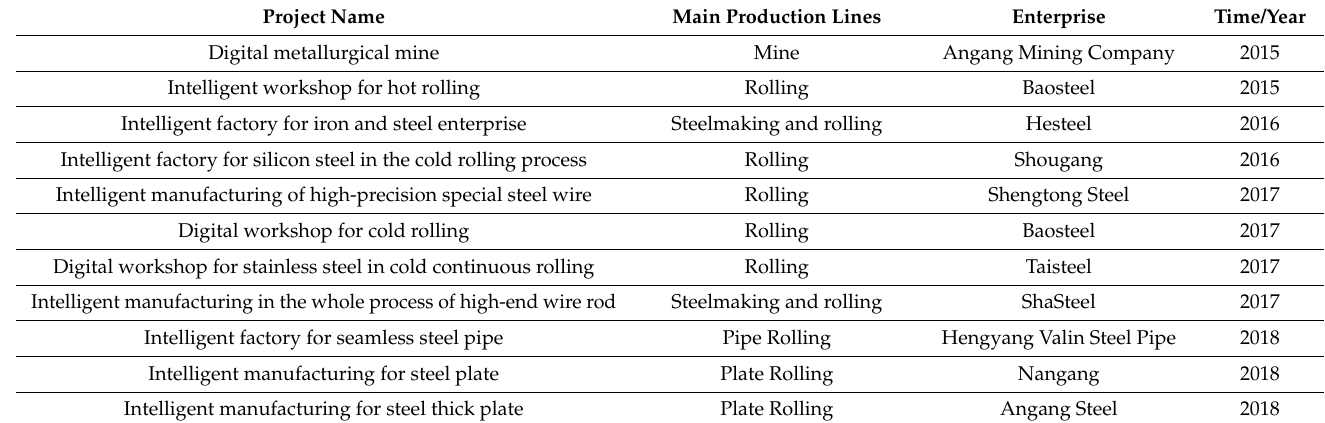
Table 1. Main intelligent manufacturing project in steel industry of